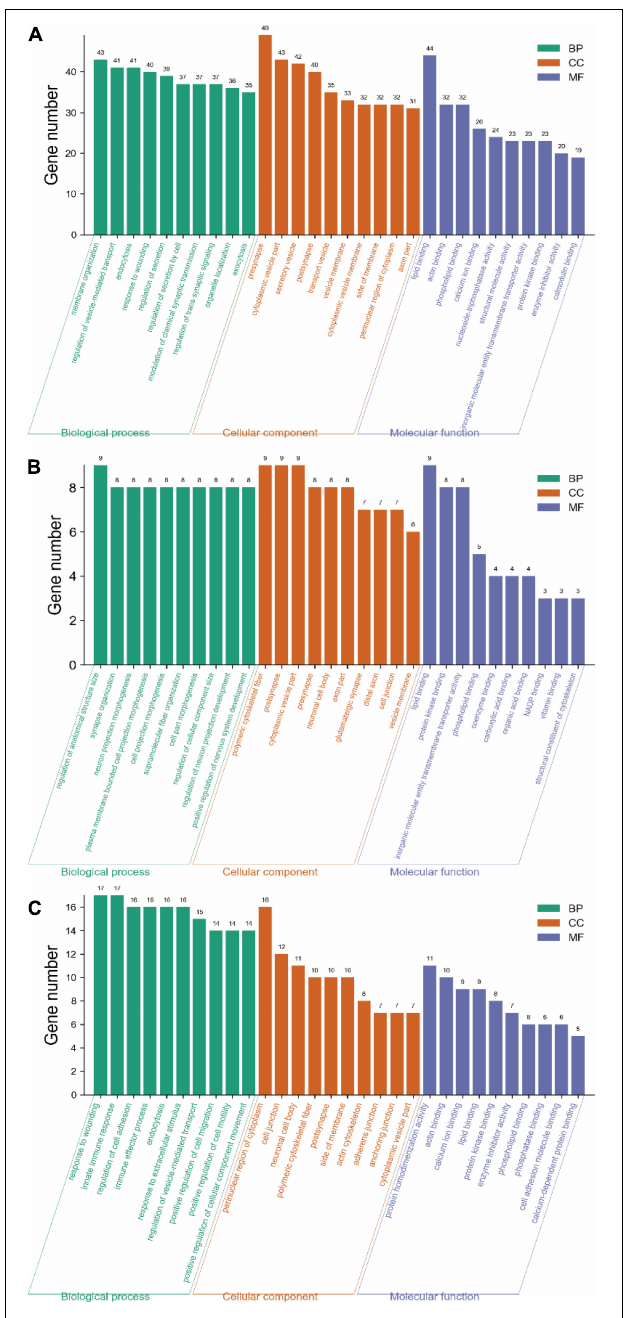
FIGURE 6 | Gene ontology analysis of DEPs on days 3 and 14 of TBI. (A) GO annotation of 312 DEPs in the Sham-a/CCI-a groups (excluding 63 shared DEPs). (B) GO annotation of 76 DEPs in the Sham-s/CCI-s groups (excluding 63 shared DEPs). (C) GO annotation of 63 overlapping DEPs in the Sham-a/CCI-a and Sham-s/CCI-s